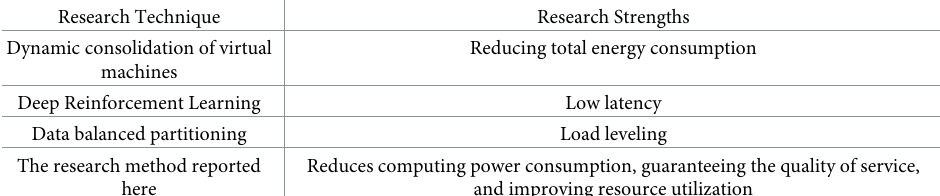
Table 1. Characteristics of domestic and foreign